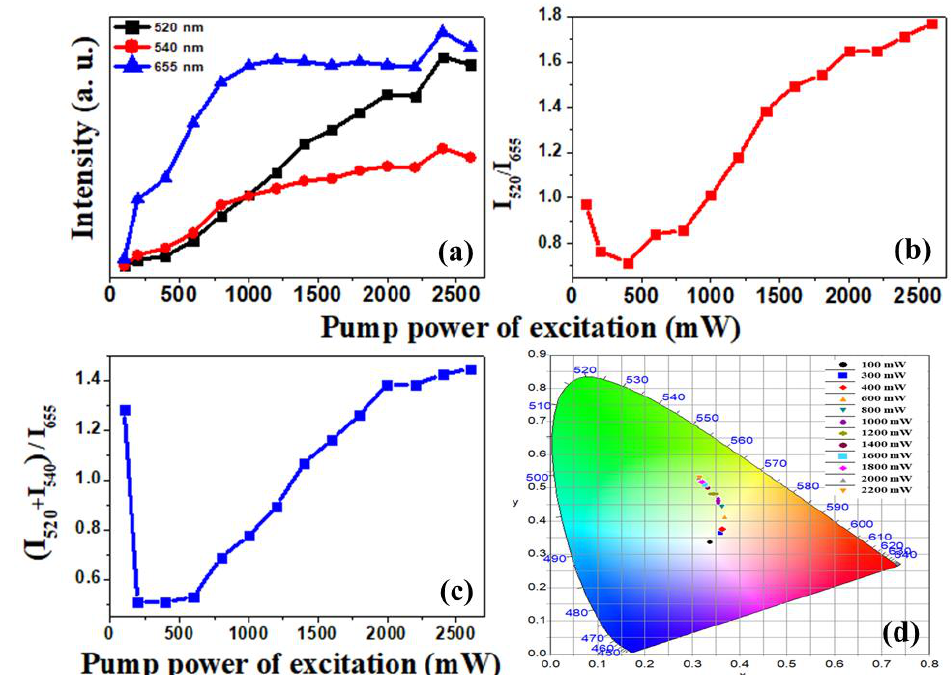
Figure 4. ( a ) A comparison of the variation of upconversion luminescence intensity with the pump power (from 100 mW to 2600 mW) at different emission bands of 520 nm, 540 nm, and 655 nm. ( b ) The ratio of intensities of the thermally coupled levels at 520 nm and 540 nm corresponds to each excitation power. ( c ) The variation of the ratio of total green to red intensities corresponds to the pump power of excitations. ( d ) CIE (International Commission on Illumination chromaticity diagram) color coordinates (x, y) representation on CIE color diagram of samples with different excitation powers.